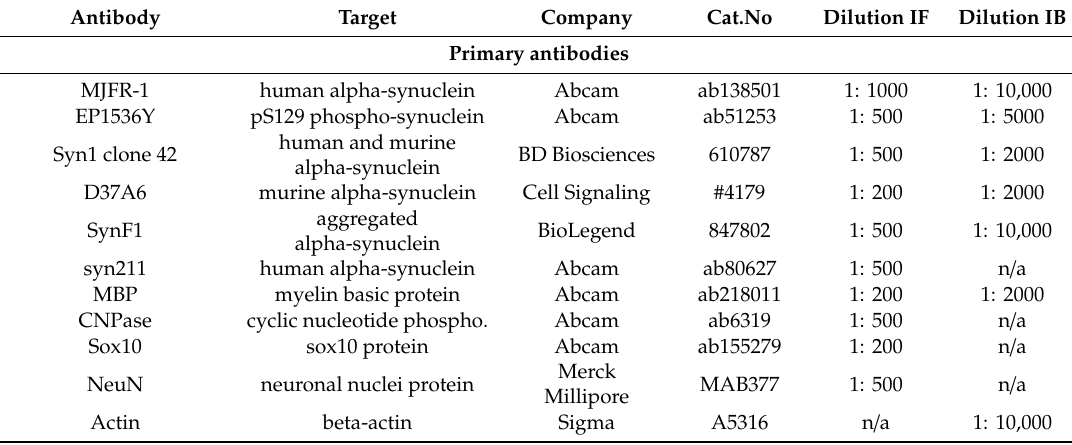
Table 1. List of antibodies used in the